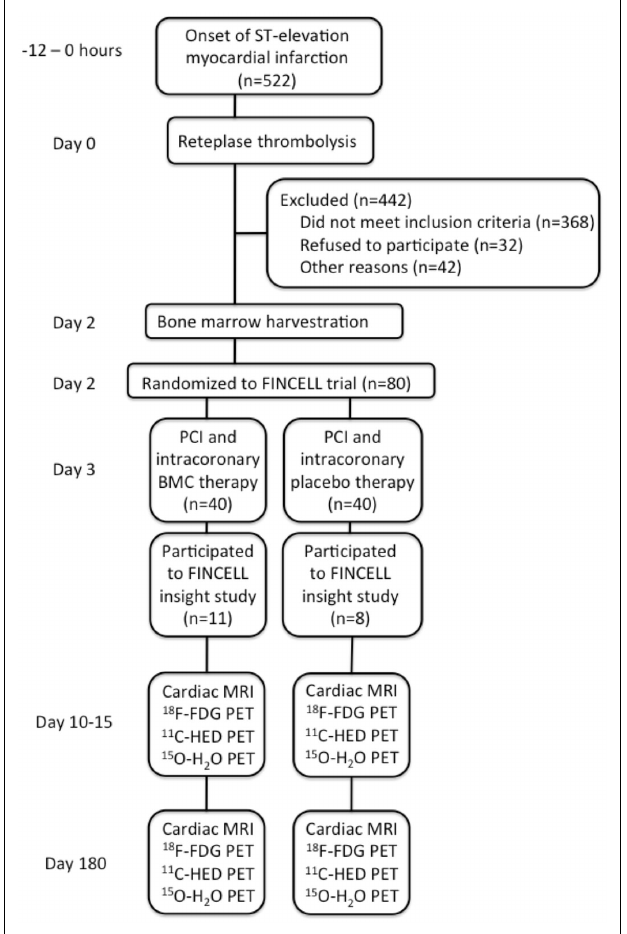
FIGURE 1 | Study flow